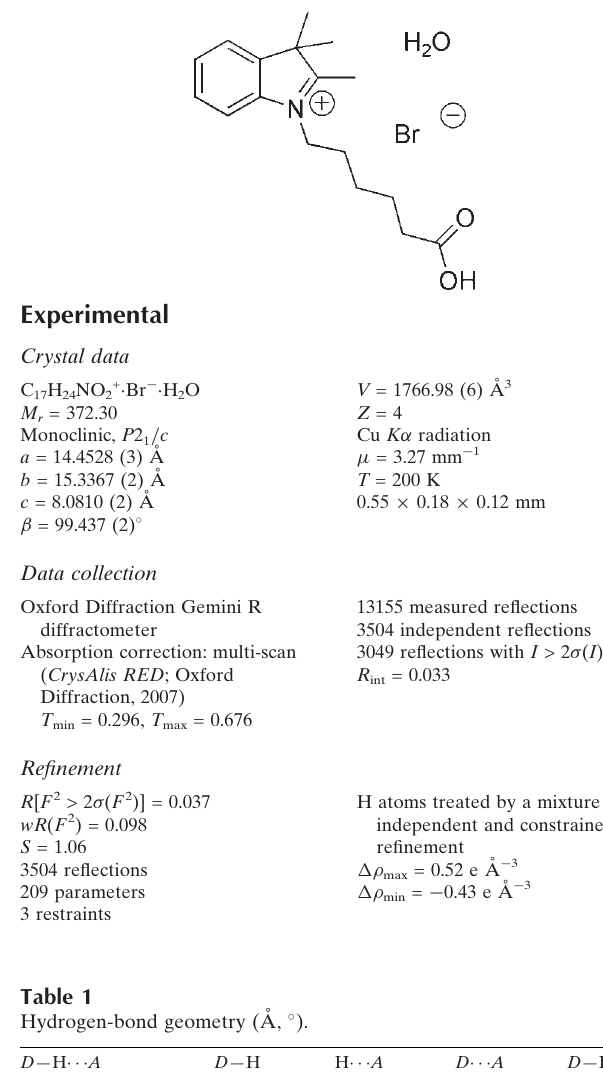
Hydrogen-bond geometry (A˚ , (cid:4) ).